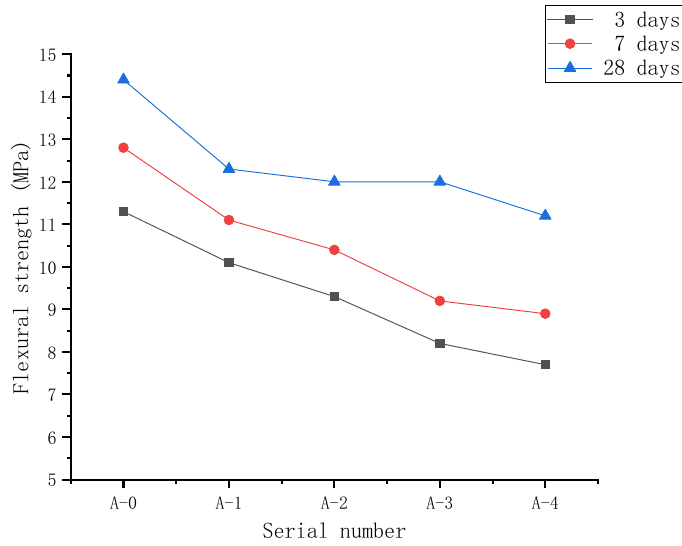
Figure 8. The flexural strength of RPC with WTSP replacing part of quartz sand.